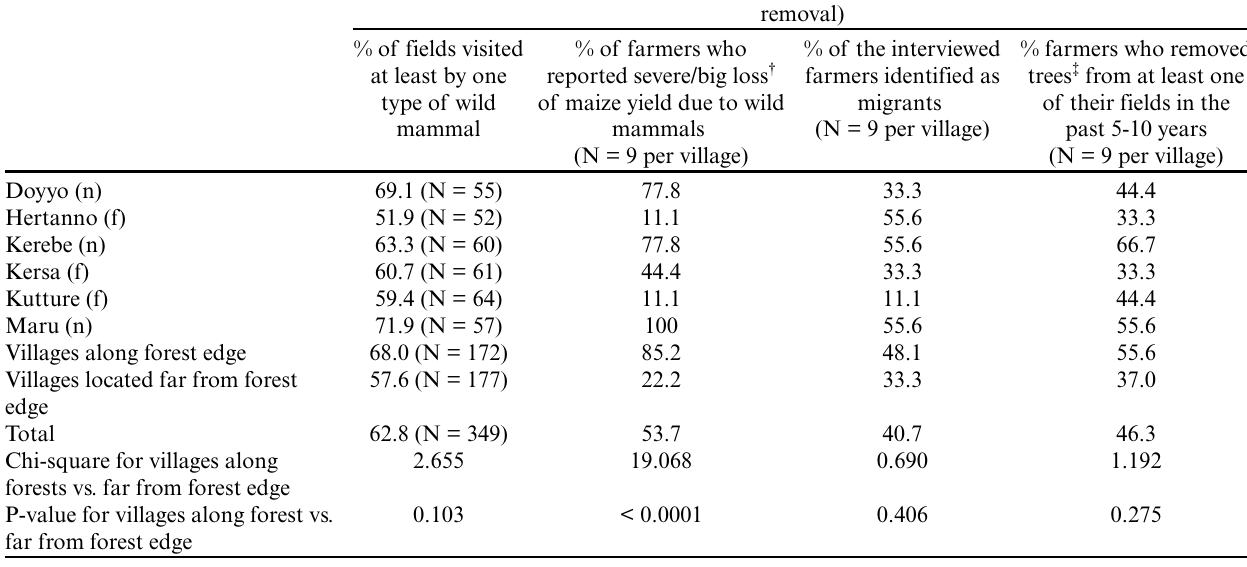
Table 5 . Issues related to farmers’ management of ecosystem disservices from and related to trees and forest (in 2011). f: Villages located far from forest edge. n: Villages located along forest edge. N: Sample size of farmers per village or number of fields per land-use type from which the percentages were calculated. † A relative estimate or report by farmers that ranges from more than a tenth to as high as over half of the total yields loss to pest raids. ‡ “Tree removal” refers to an act in which farmers removed certain trees from existing fields and incorporated into existing fields or converted forest to agricultural